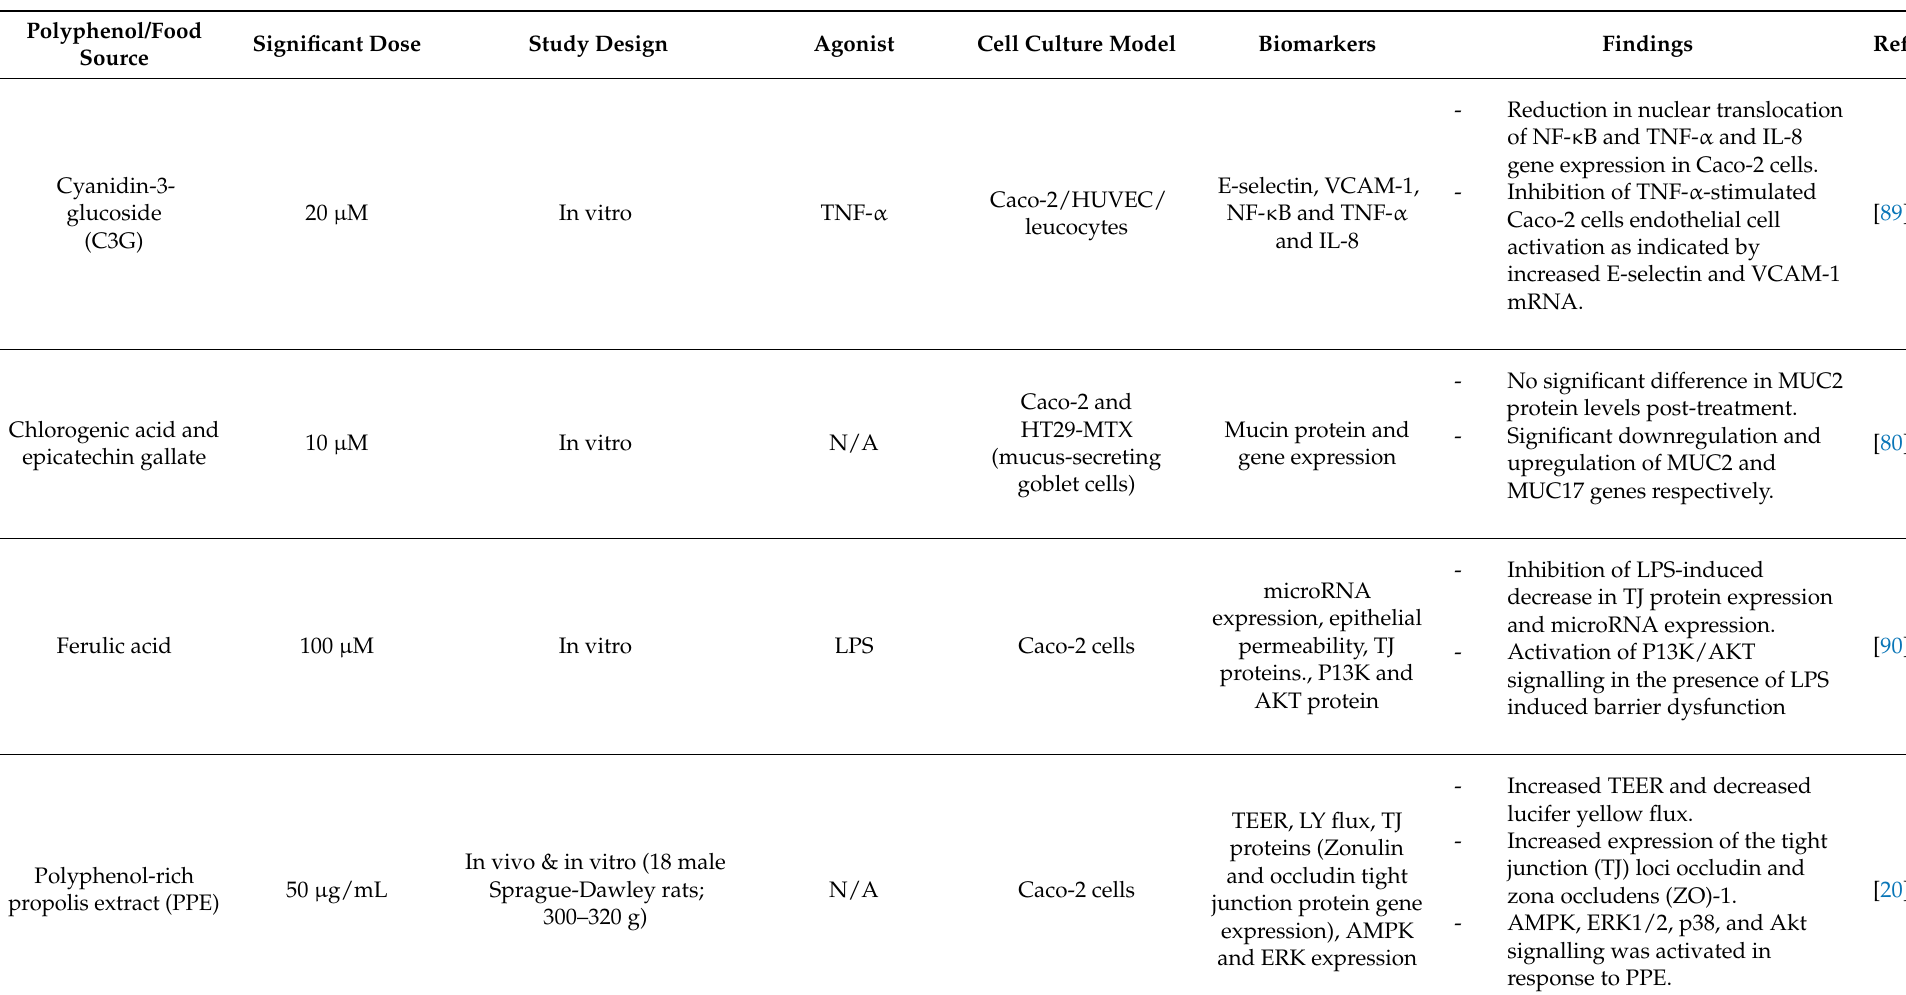
Table 3. The impact of dietary polyphenols on intestinal barrier function compromised by inflammation and oxidative stress